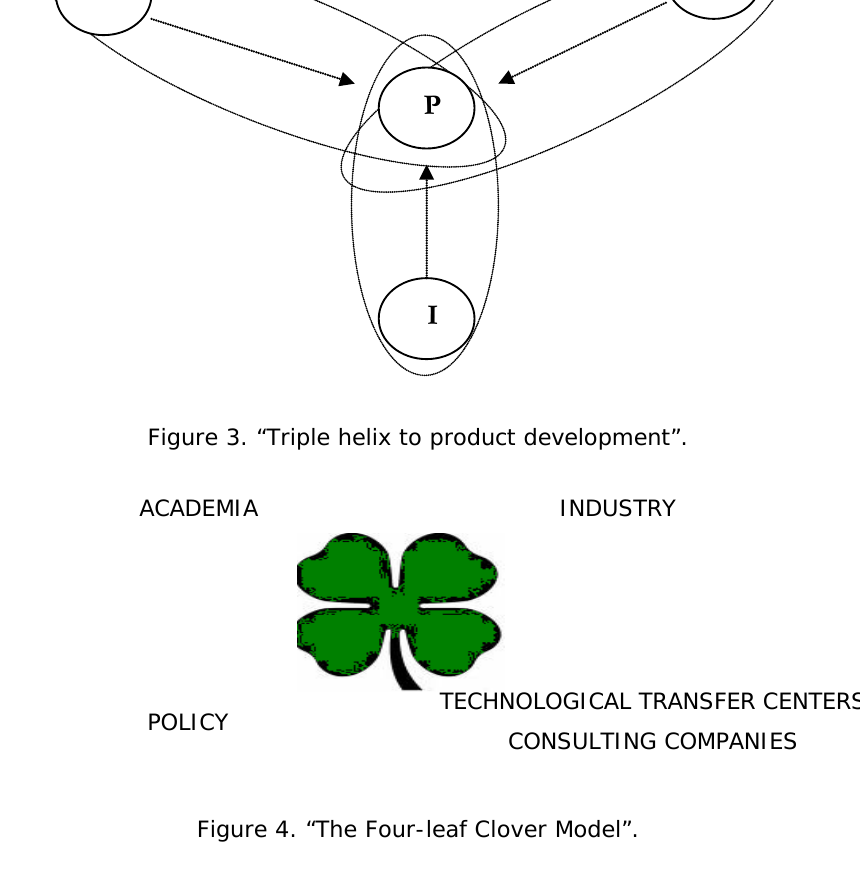
Figure 4. “The Four-leaf Clover Model”.